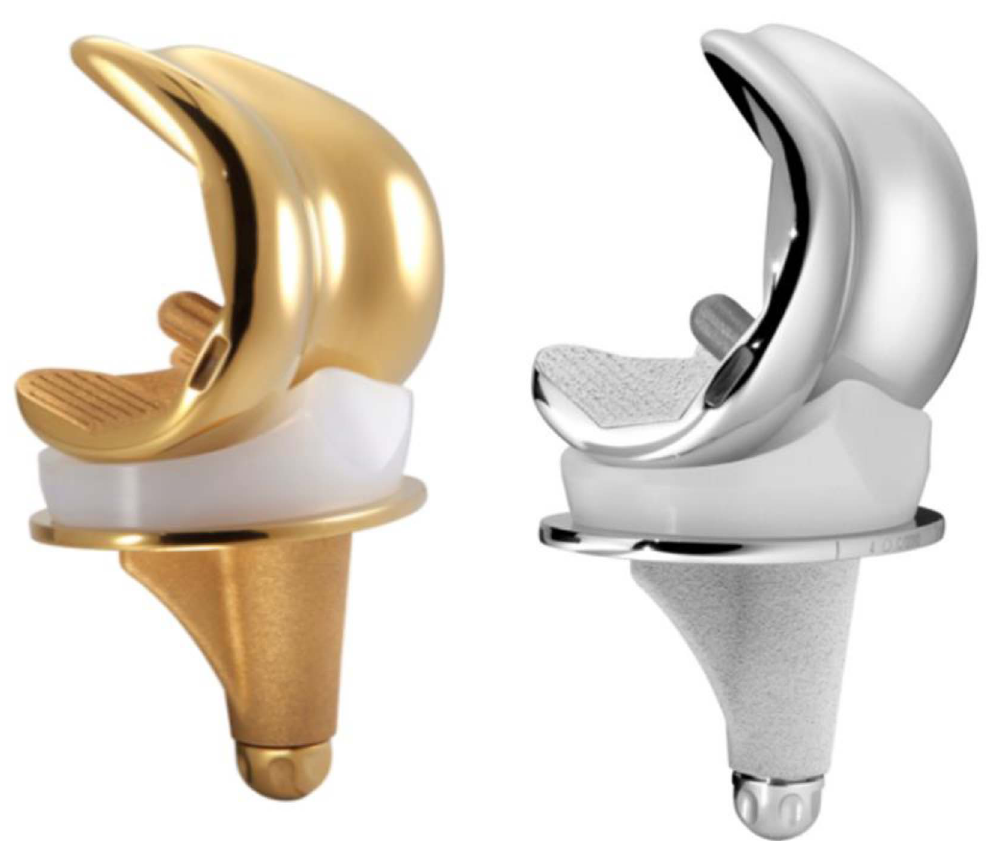
Figure 1. TiN-coated (Score AS) and uncoated CoCrMo (Score II) mobile bearing prostheses ( reproduced with permission from www.amplitude-ortho.com).